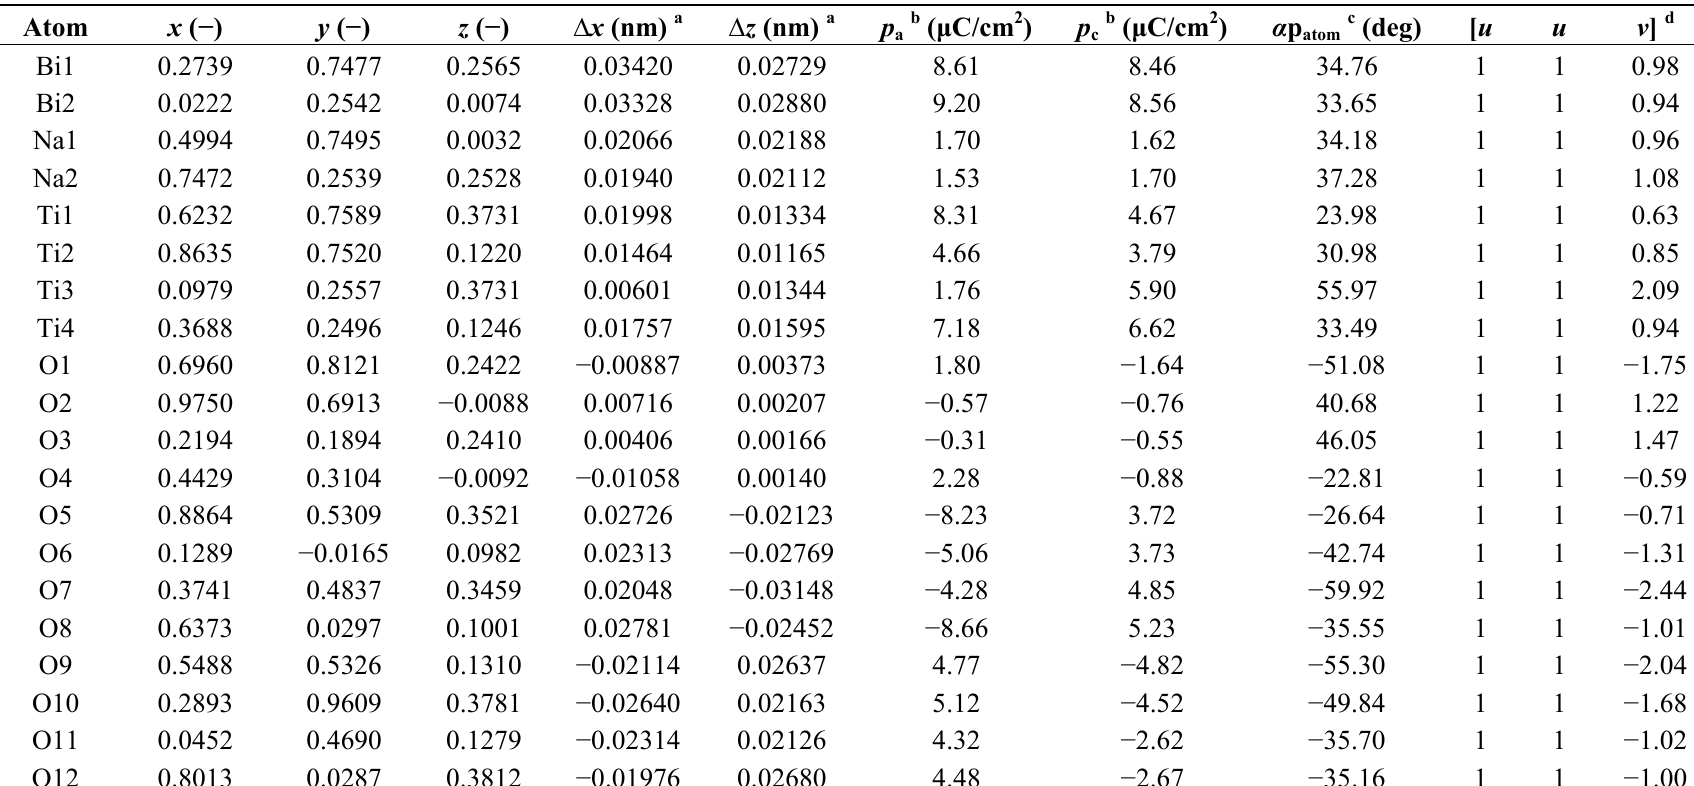
Table 6. Structural parameters obtained by the DFT calculations for BNT–5%BT ( E parameters were used: a = 0.55306 nm, b = 0.55037 nm, c = 1.65152 nm, α = γ = 90.0000°, and β = 70.2530°. The P angle ( α ) of 36.0° is m